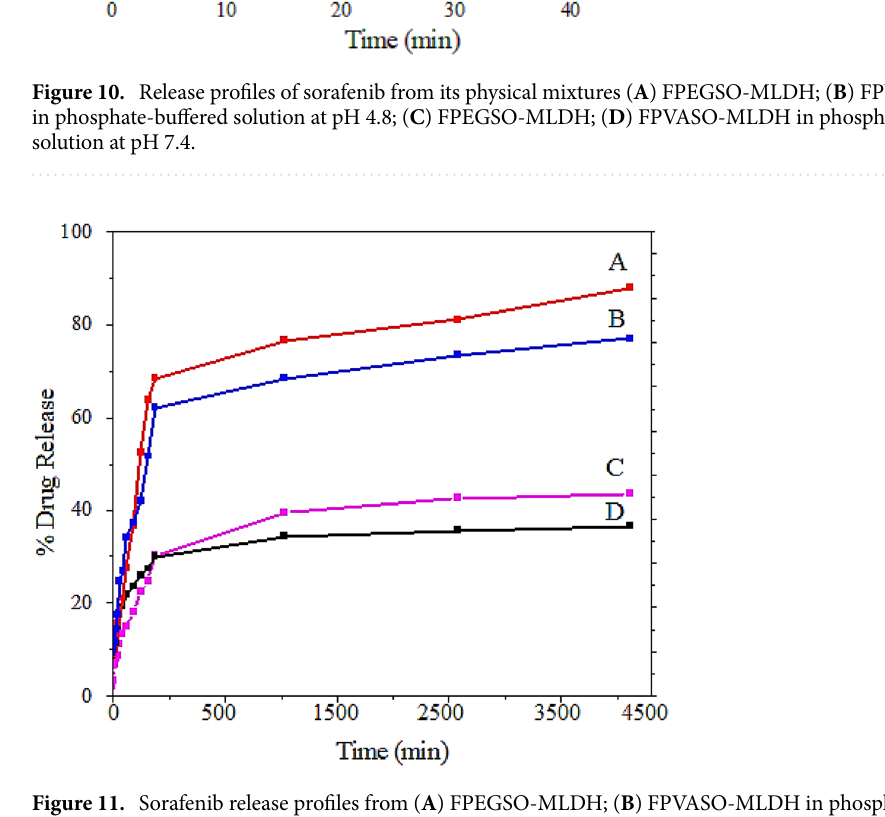
Figure 11. Sorafenib release profiles from ( A ) FPEGSO-MLDH; ( B ) FPVASO-MLDH in phosphate-buffered solution at pH 4.8; ( C ) FPEGSO-MLDH; ( D ) FPVASO-MLDH in phosphate-buffered solution at pH